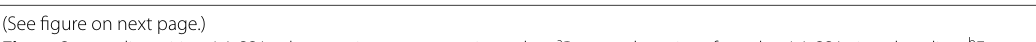
figure on next Fig. 1 Survey disposition. LA SSA long-acting somatostatin analog. a Reported receipt of another LA SSA since baseline. b Four completed but not = submitted baseline surveys were moved to completed status at the end of data collection. c There were 2 patients who screened into the baseline survey, which indicated that it had been less than 5 days since their most recent LA SSA injection. These patients later provided the date of their last injection as occurring 15 and 25 days before taking the survey. The completed surveys for these 2 patients were not included in the analysis data